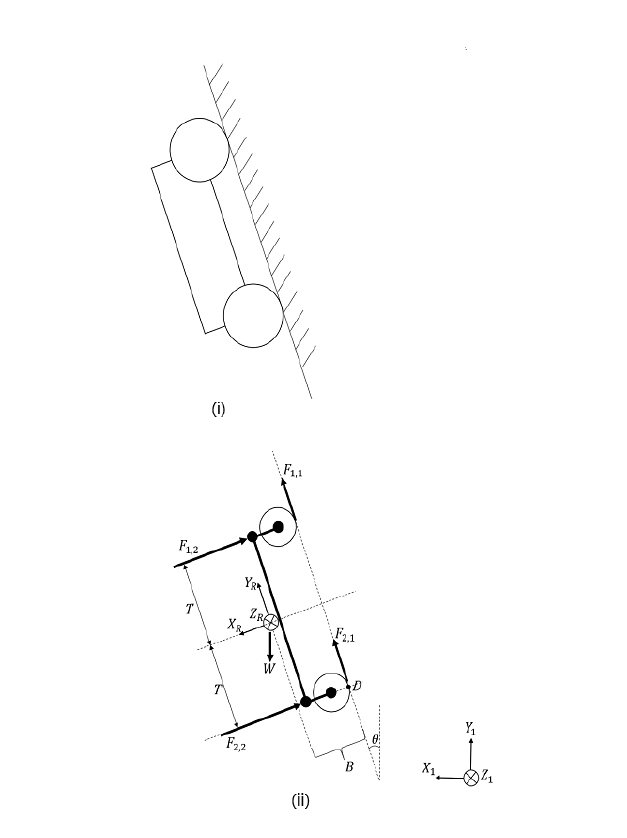
Figure 2. ( i ) Typical setup of Robot and ( ii ) Static Force Analysis in Robot